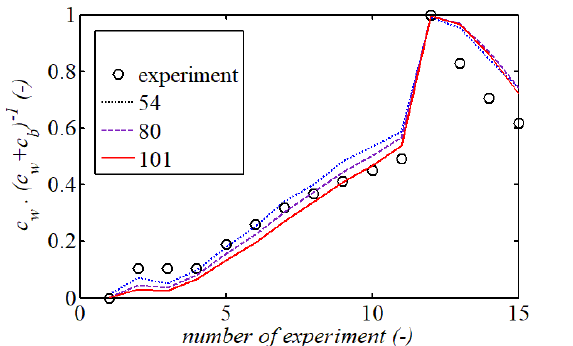
Fig. 8. The result of relative concentration of white particles for three values of boundary white and invariable value for boundary of black